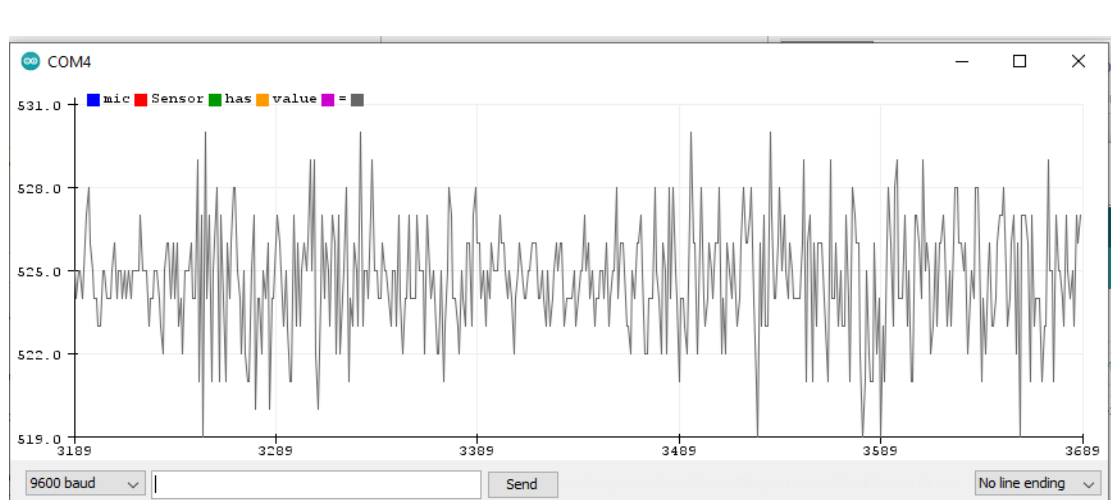
Figure 11. Background noise waveform.